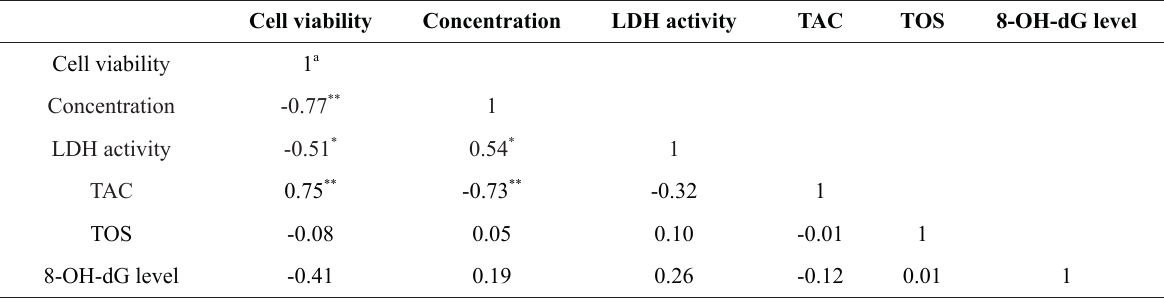
Correlation between different variables for PMGN cells exposed to ULE.